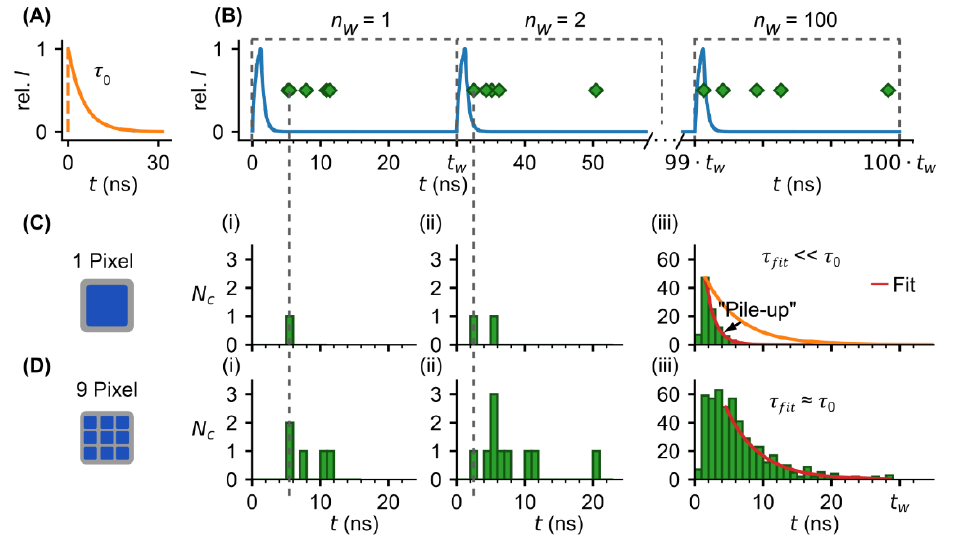
Figure 1. TCSPC-based FL measurements using SPAD array detector. ( A ) “Ideal” fluorescence signal (intensity vs. time) of a fluorophore with a single-exponential decay characterized by its lifetime τ 0 . ( B ) Lifetime measured by TCSPC. Fluorophores are excited with a short laser pulse (blue curve) and the arrival times of emitted fluorescence photons (green markers) are detected by a single-photon detector, e.g., PMT or SPAD array detector. To obtain a sufficient number of arrival times, laser excitation and photon counting are repeated for n w -times with a defined measurement window duration t w . All arrival times are stored in a histogram allowing to extract the lifetime by exponential fit ( Ciii , Diii ). The count rate during each measurement window depends on the number of individual photosensitive areas or pixels of the detector ( C , D ). With “one-pixel” single-photon detector, only the first photon per measurement window can be detected ( Ci , Cii ). In case of high photon rates (photons per measurement window), this “first - photon” issue leads to a pile -up of the histogram and an underestimation (lower accuracy) of the lifetime as indicated by difference between the fit (red curve) and ideal fluorescence signal (orange curve from ( A )) ( Ciii ). To avoid pile-up, the photon rate should be smaller than the number of pixels. With “pixelated” SPAD array detector higher photon rates can be permitted ( D , here, pixels=9 > photon rate < 𝑁 𝑐 > 𝑤 = 5 ) resulting in higher total counts ( Di, Dii ) and a more accurate estimation of the lifetime ( Diii ) compared with one pixel ( Ciii ) after the same number of measurement windows (i.e., same total measurement time).